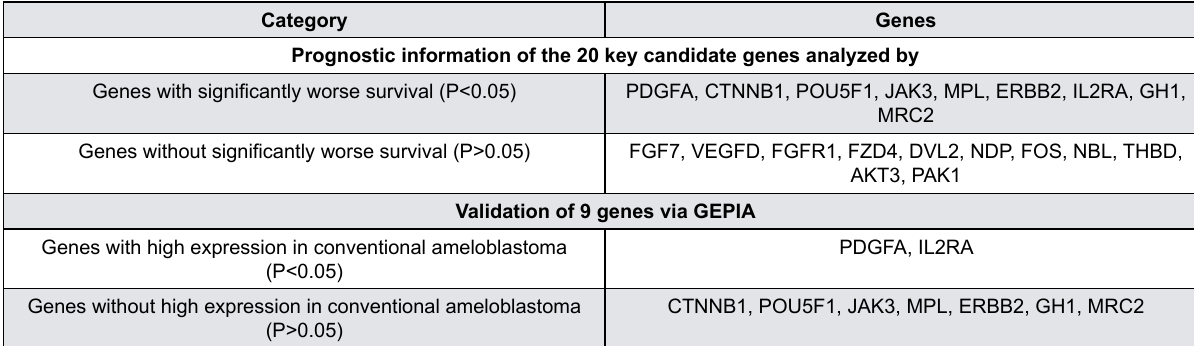
Figure 3- Selection of candidate